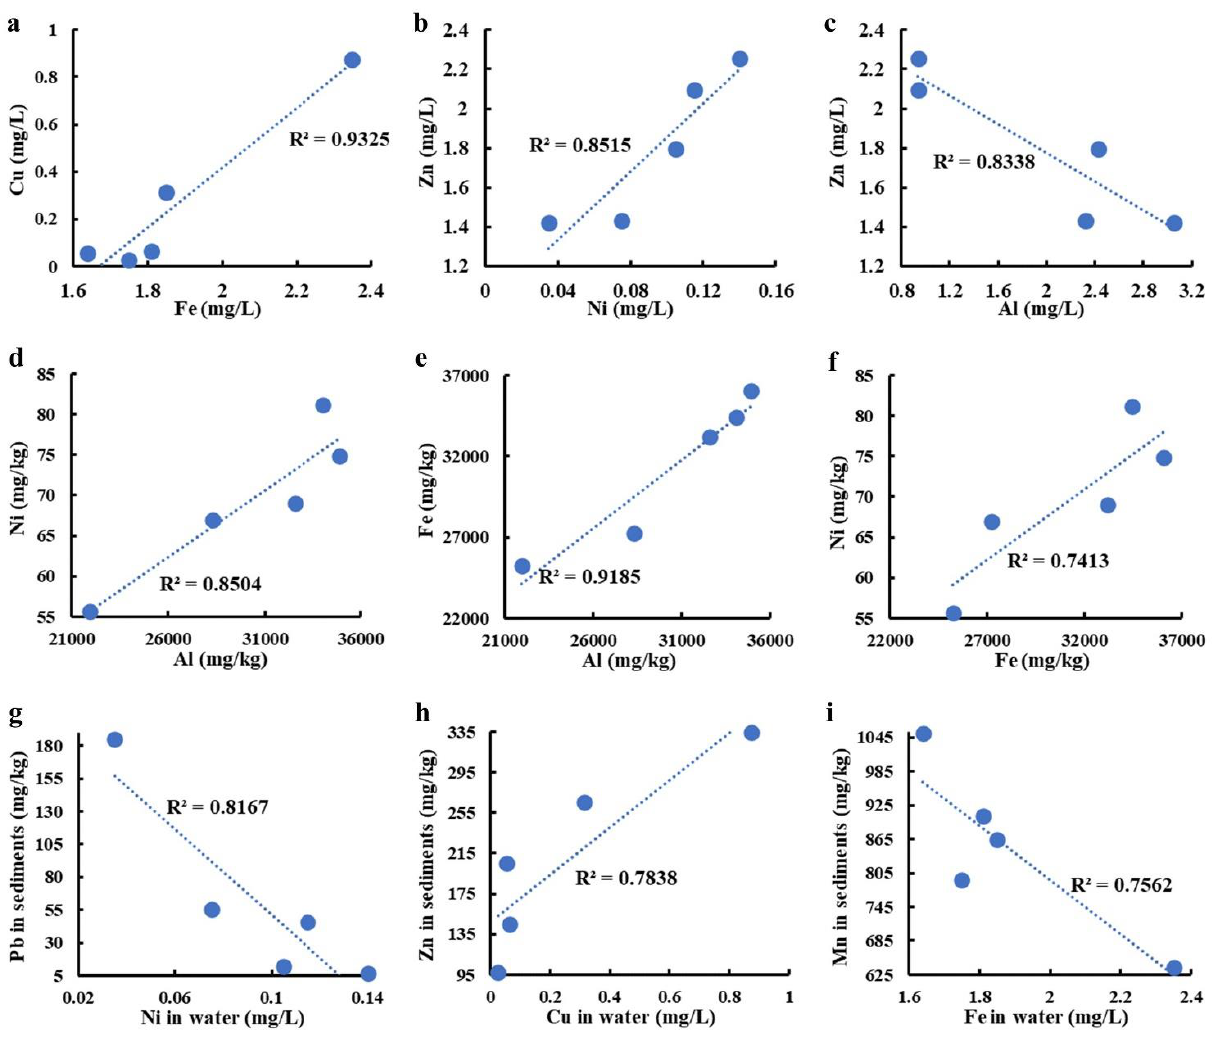
Figure 4. Bivariate plots of significant relationships between heavy metals in water and sediments of Bahr El-Baqar drain: Cu versus Fe ( a ), Zn versus Ni ( b ), and Zn versus Al ( c ) in water (mg/L); Ni versus Al ( d ), Fe versus Al ( e ), and Ni versus Fe ( f ) in sediments (mg/kg); Pb in sediments (mg/kg) versus Ni in water (mg/L) ( g ), and Zn in sediments (mg/kg) versus Cu in water (mg/L) ( h ), and Mn in sediments (mg/kg) versus Fe in water (mg/L) ( i ).